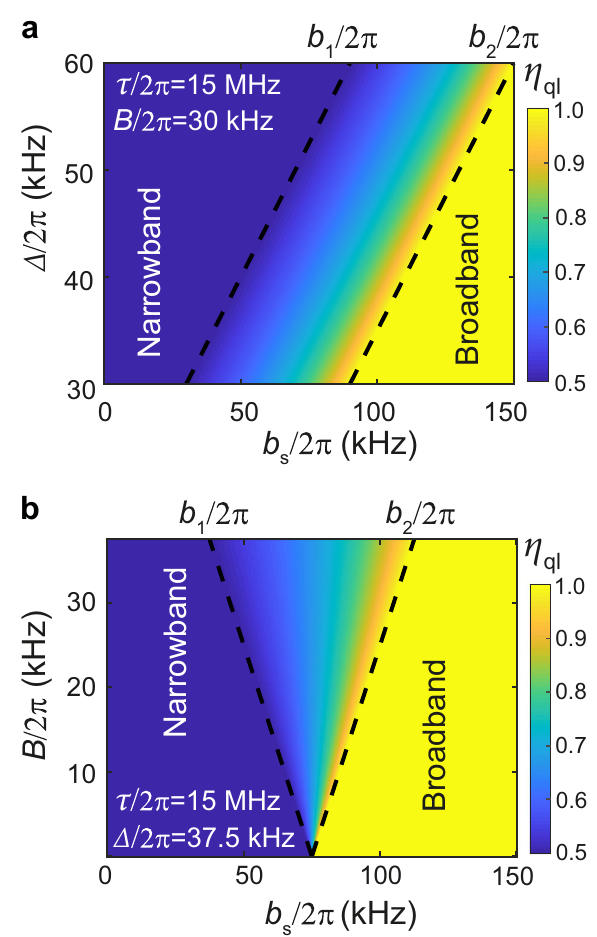
Fig. 2 Theoretical limits on quantum ef fi ciency. Limit η ql of the quantum ef fi ciency η as a function of the signal bandwidth b s for a varying detuning Δ at a fi xed measurement bandwidth B /2 π = 30 kHz and b for varying measurement bandwidth B at a fi xed detuning Δ /2 π = 37.5 kHz, according to Eq. (8). For b s ≥ b 2 , ampli fi cation with η = 1 is possible. The case b s ≤ B is only of technical interest and is discussed in the supplement (see Supplemental Material).